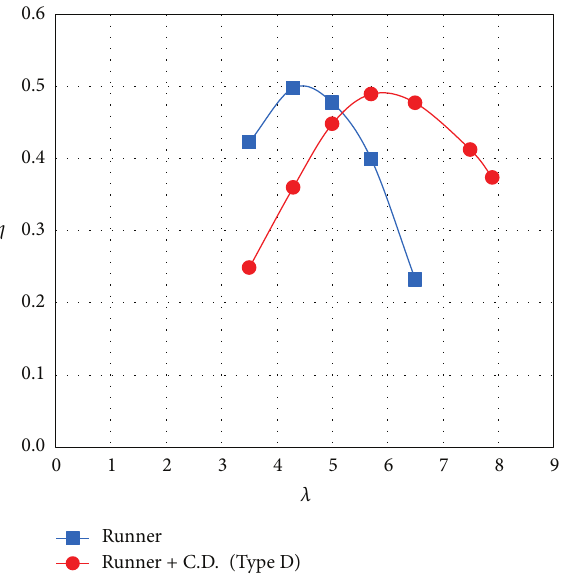
Figure 13: Correlation between the tip speed ratio and the loading coefficient.